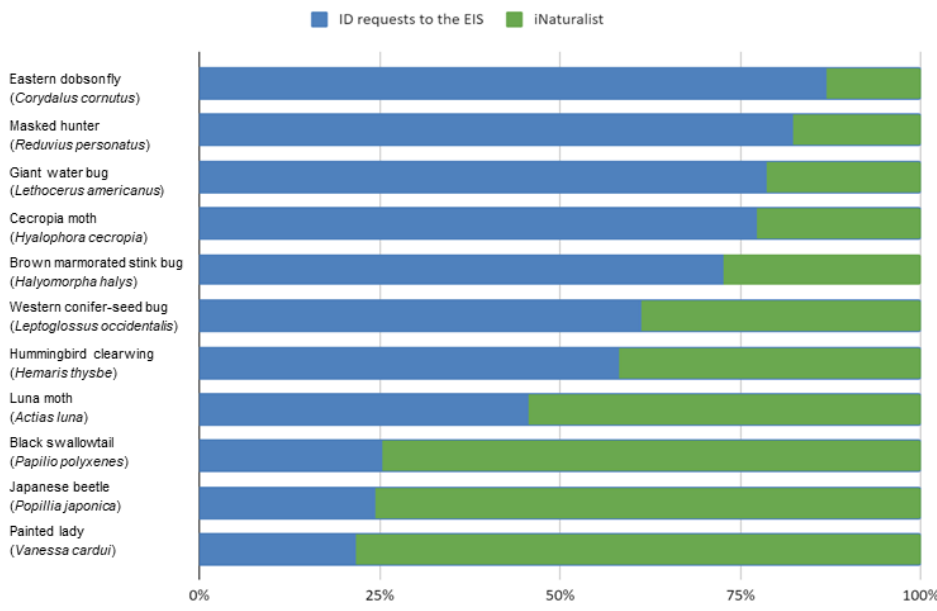
Figure 3. Order-level taxonomic distribution of general information requests received by the Mon- treal Insectarium’s Entomological Information Service in 2010, 2011, 2017 and 2018.